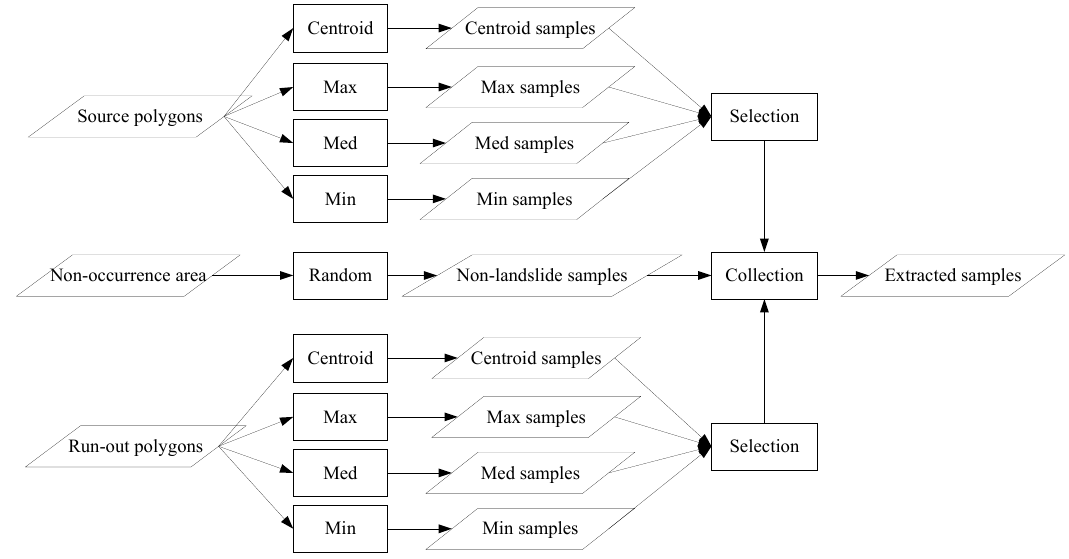
Figure 4. Sampling strategy procedure used to extract landslide causative factors to prepare training and check datasets; Max, Med, and Min represent maximum, median, and minimum operators, respectively. Table 3. Three analytical schemes for constructing landslide susceptibility models.